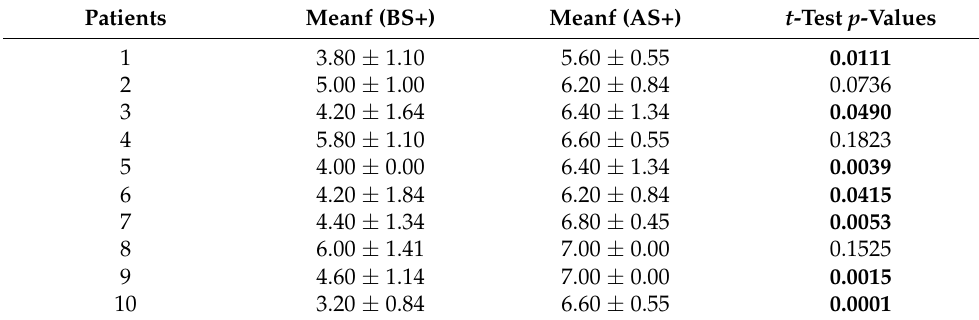
Table 3. Statistical analysis of the Alzheimer patients’ group. Marked in bold are the statistically significant results ( p < 0.05).